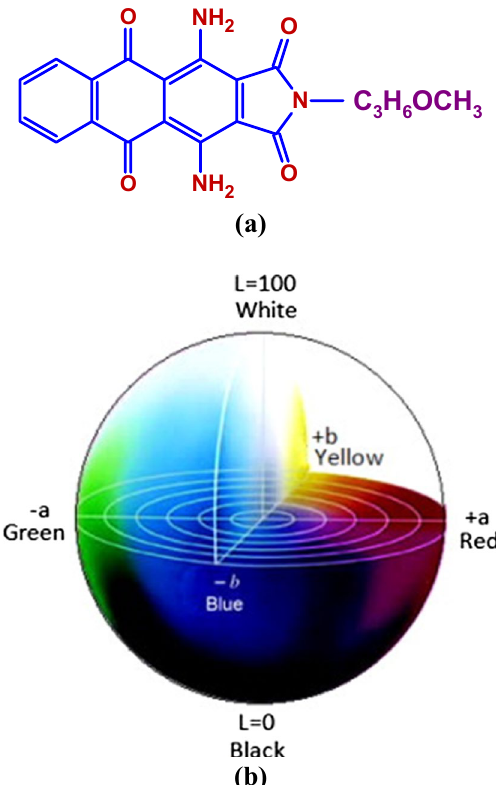
Figure 6. ( a ) Chemical structure of Turquoise Blue S-GL (Disperse Blue 60) and ( b ) The color parameters L*, a* and b* model from CIELAB color space 27 .